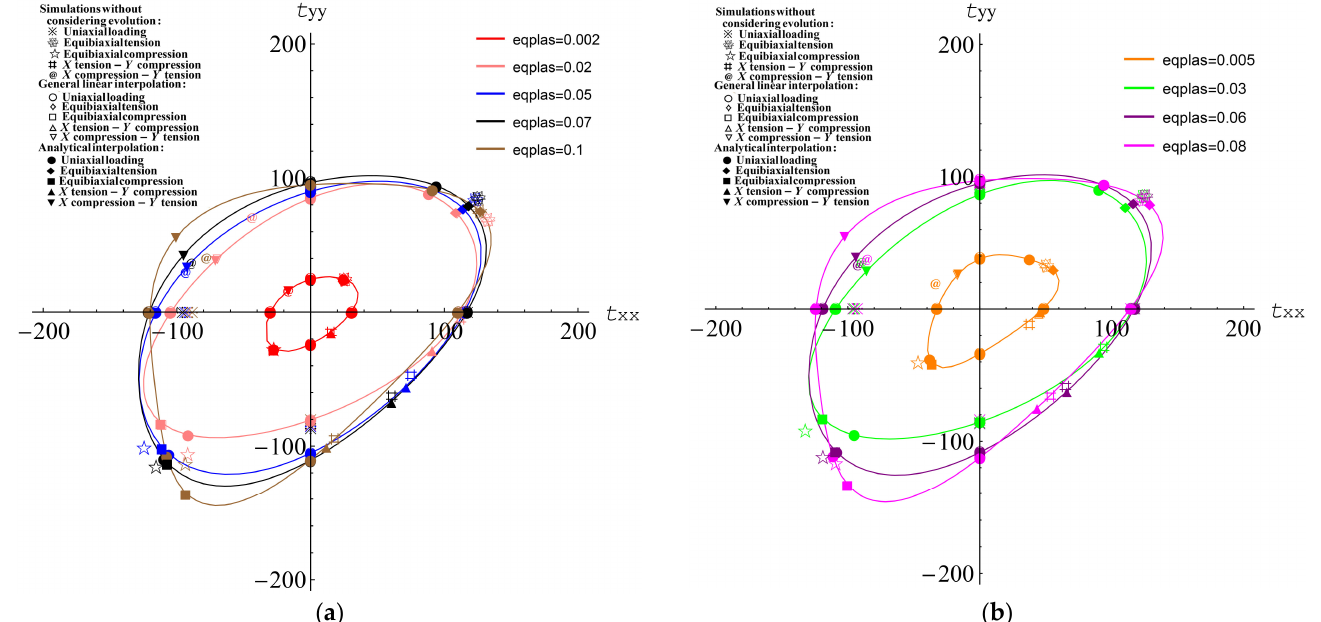
Figure 7. Finite element method (FEM) simulations of continuous large deformation uniaxial and biaxial loading of ZK60 magnesium alloy (unit: MPa): ( a ) data at accumulative plastic strains of 0.002, 0.02, 0.05, 0.07, and 0.1. ( b ) data at accumulative plastic strains of 0.005, 0.03, 0.06, and 0.08.